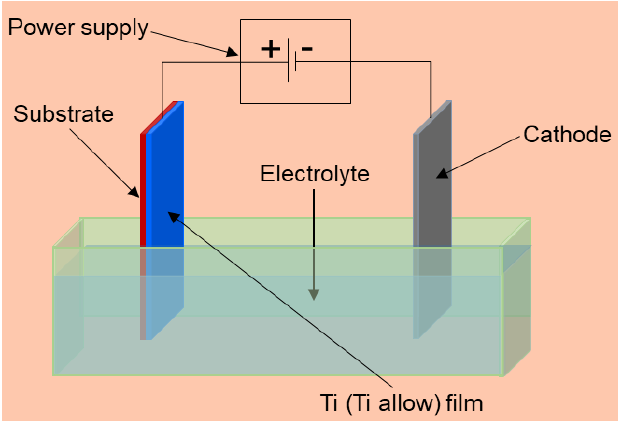
Figure 6. Schematic of an electrochemical anodization system.